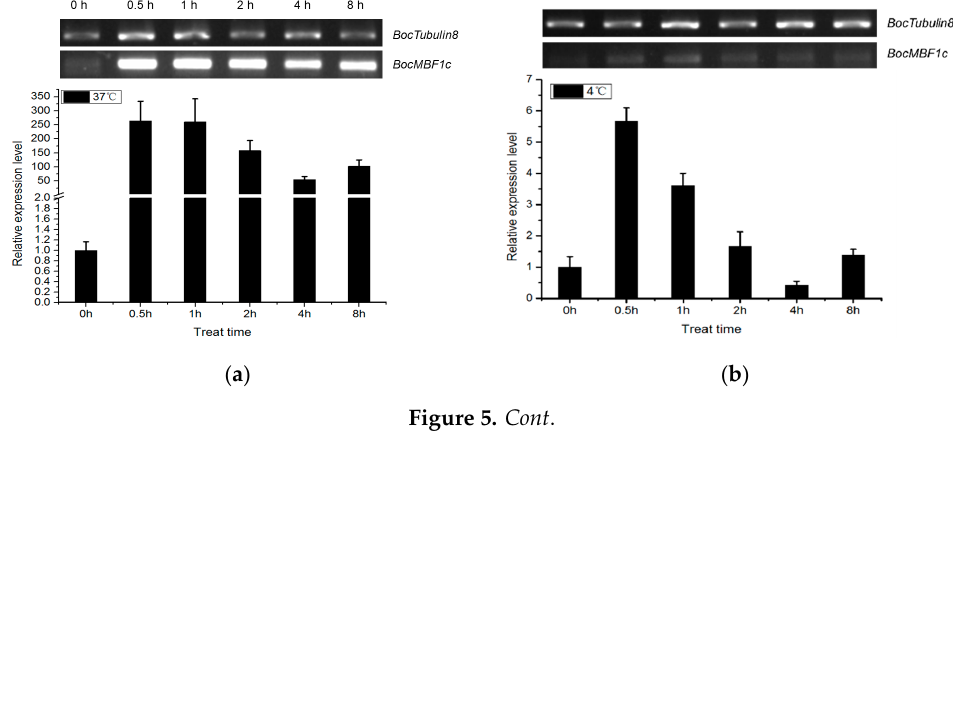
Figure 4. The expression pattern of BocMBF1c in different tissues under standard growth conditions. ( a ) Various tissues of Chinese kale. SL, senescent leaf; ML, mature leaf; YL, young leaf; LV, leaf vein; Pe, petiole; YB, young bolting stem flesh; MB, middle bolting stem flesh; BSS, bolting stem skin; FB, flower buds; CS, combining sites between stem and root; Ro, Roots. ( b ) Bolting stage tissues were harvested for expression specificity analysis. Quantitative PCR (qPCR) was used to measure BocMBF1c expression in different tissues, with the BocTubulin8 gene as the control. Data shown are the mean ± SD of three biological replicates.